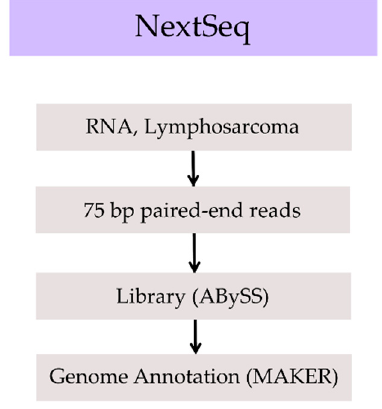
Figure 2. Transcriptome assembly workflow.